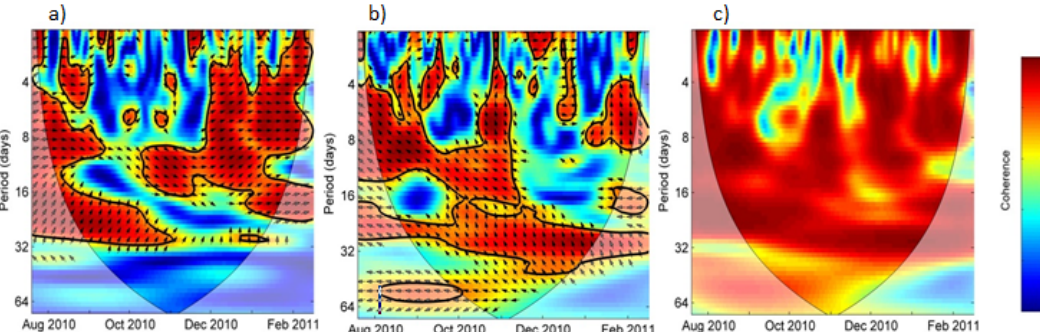
Figure 4. Wavelet power spectra (top) and time series plot (bottom) of along ‐ shelf wind stress ( a ; τ x ); cross ‐ shelf wind stress ( b ; τ y ); and PC1 ( c ). Wavelet power is normalized by the variance of each time series.